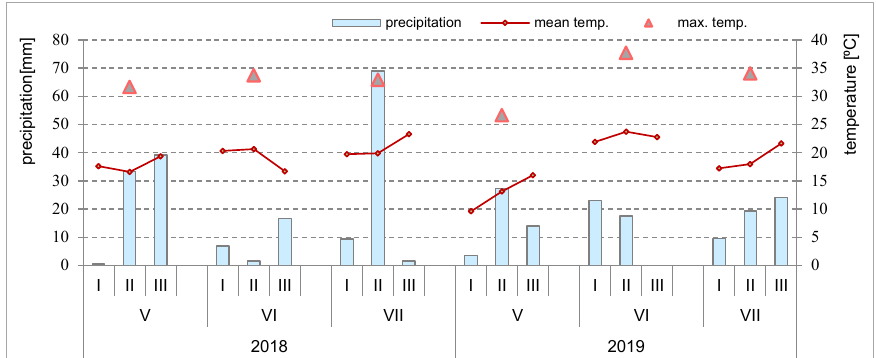
Figure 1. Temperature and precipitation in the fields where the experiment was performed: mean and maximum temperatures and precipitation during plant development stages from heading to physiological maturity in 2018 and 2019.